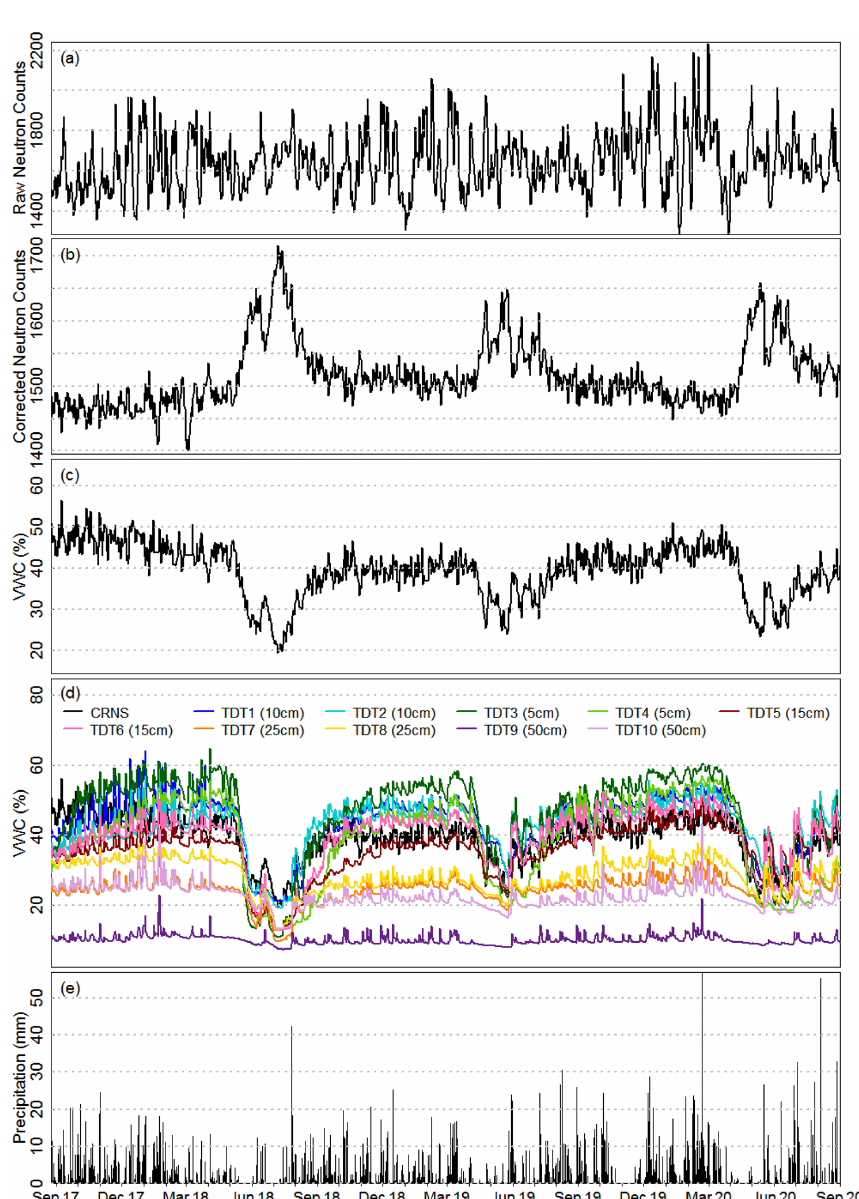
Figure 5. Daily COSMOS-UK data for the Cochno site in Scotland. (a) Raw neutron counts from the CRNS (aggregated from hourly totals); (b) neutron counts corrected for pressure, humidity, and background count intensity (aggregated from hourly totals); (c) VWC determined from the CRNS-corrected counts and corrected for snow; (d) CRNS VWC and point TDT VWC at a series of depths; (e) precipitation. Note the 2018 cold wave and summer heatwave impact on soil